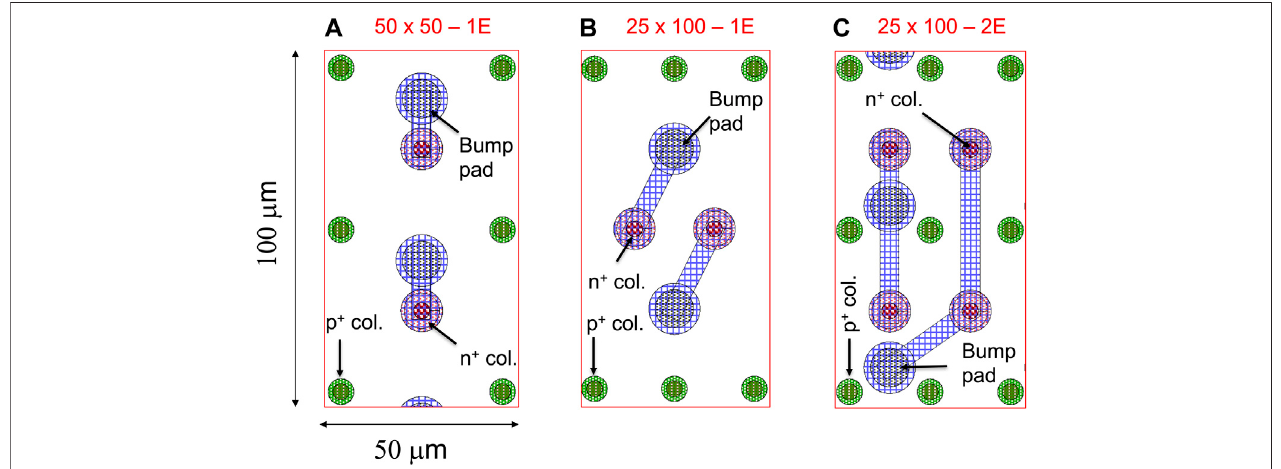
FIGURE 3 | 3D pixel layouts, showing pairs of adjacent pixels (FBK